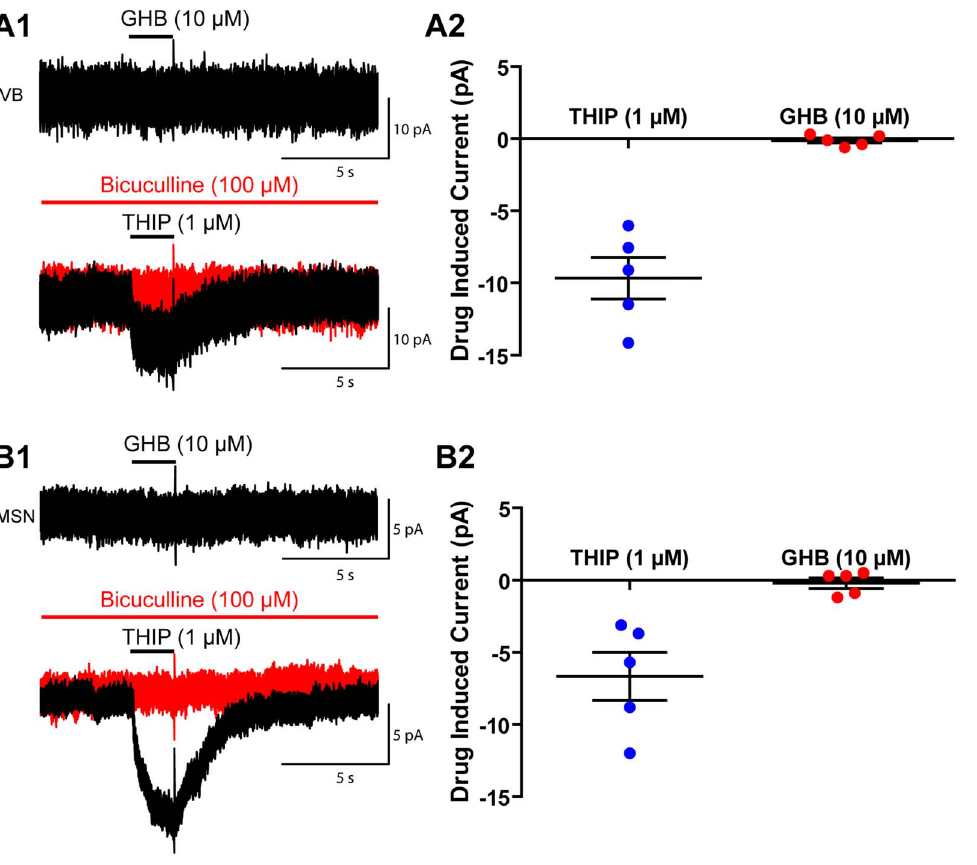
Figure 3. Puff application of GHB has no effect on nucleated patches pulled from VB thalamocortical cells, or medium spiny neurons. A1, Example traces showing the effect of 2 second puff applications of GHB (10 m M) and THIP (1 m M) to nucleated patches of thalamocortical VB neurons. A2, Group results showing the magnitude of the effect of THIP and GHB in VB neurons. B1, Example trace showing the effect of 2 second puff application of GHB (10 m M) and THIP (1 m M) to nucleated patches of medium spiny neurons. A2, Group results showing the magnitude of the effect of THIP and GHB in medium spiny neurons.